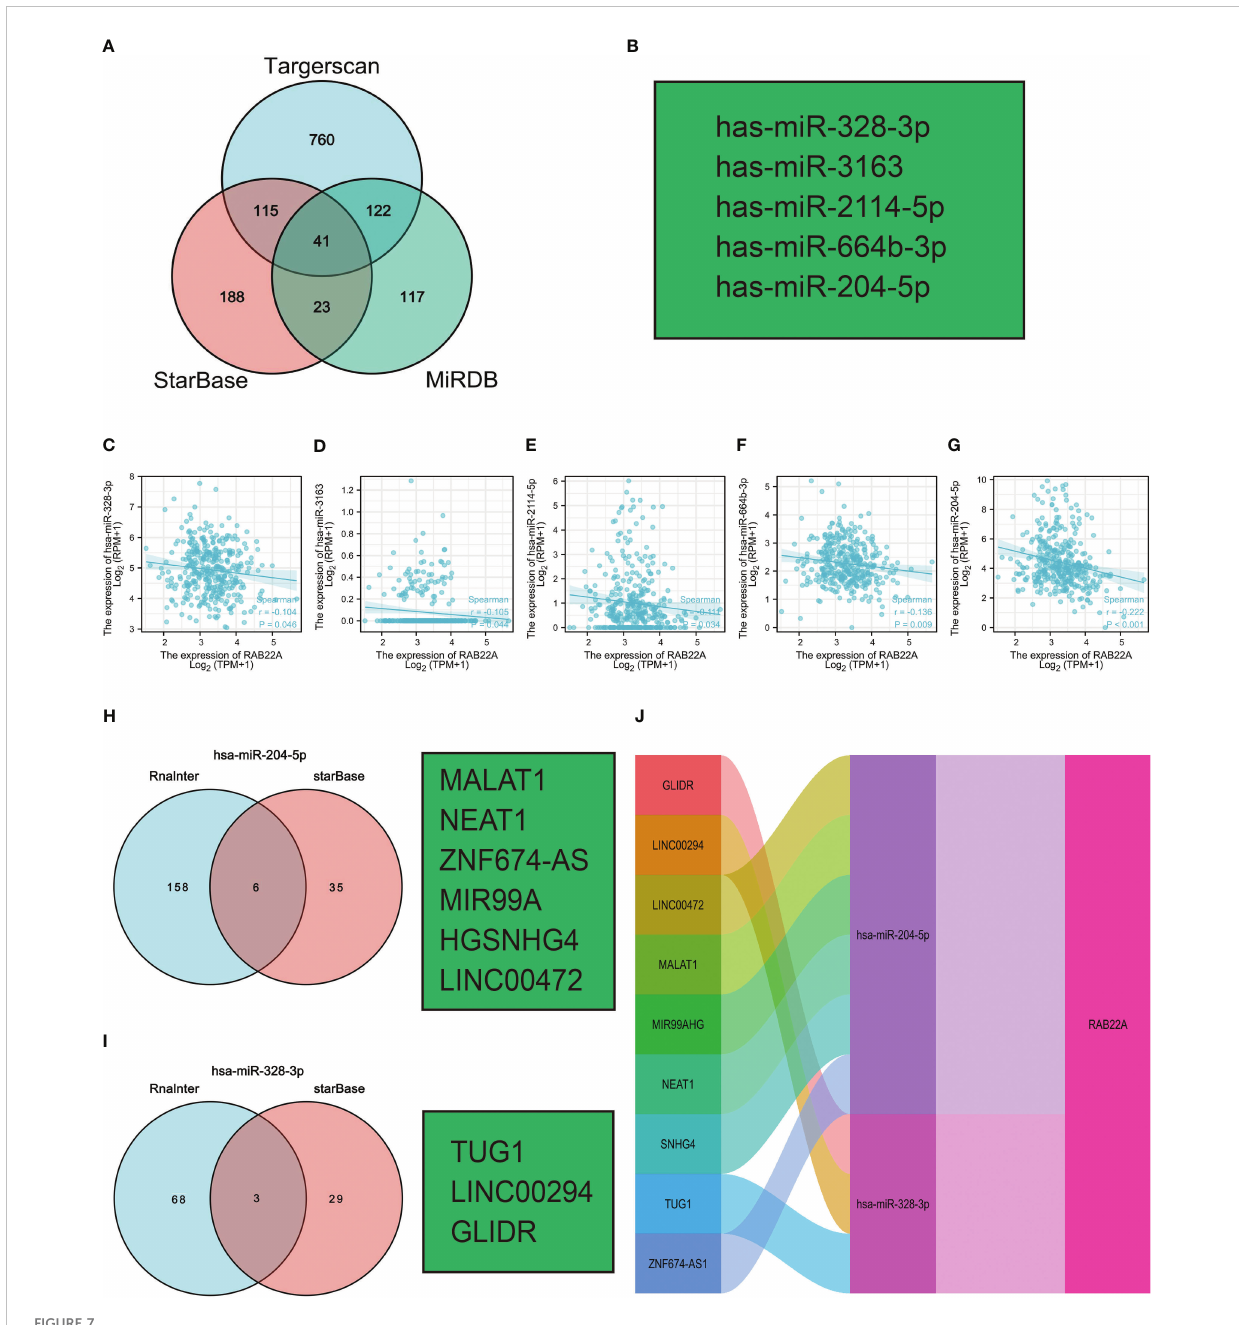
FIGURE 7 Prediction of ceRNA networks in HCC. (A) Venn diagram results showing 41 overlapping miRNAs in Targerscan, starBase, and MiRDB databases. (B) Five miRNAs screened for negative correlation with RAB22A expression. (C – G) Scatter plots showed that miRNAs were signi fi cantly correlated with mRNAs. (H, I) Prediction of lncRNAs bound to target miRNAs using miRNet and starBase online databases and displayed as a Venn diagram, including hsa-miR-204-5p and hsa-miR-328-3p. (J) Sankey diagram showing the RAB22A -related ceRNA regulatory